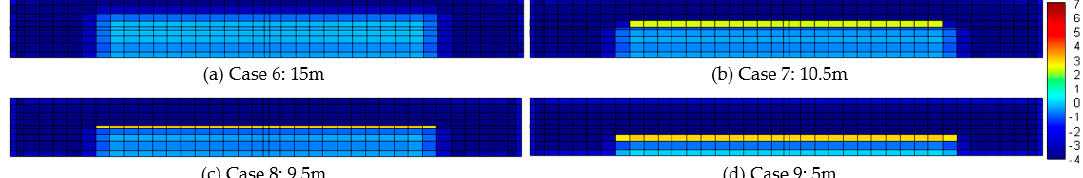
Figure 21. Comparison of conductivity distribution between different cases after 10 years, lg( k HF · d HF /md-m). Figure 20. Comparison of σ xx distribution between different cases after 10 years, MPa. The profiles are shown in the top, middle and bottom layers, and the length in the z -direction is shown as 6.67 times the real size.